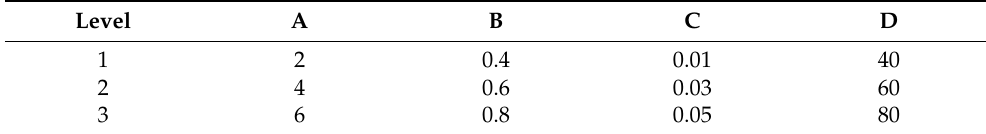
Table 2. Orthogonal level factor table.